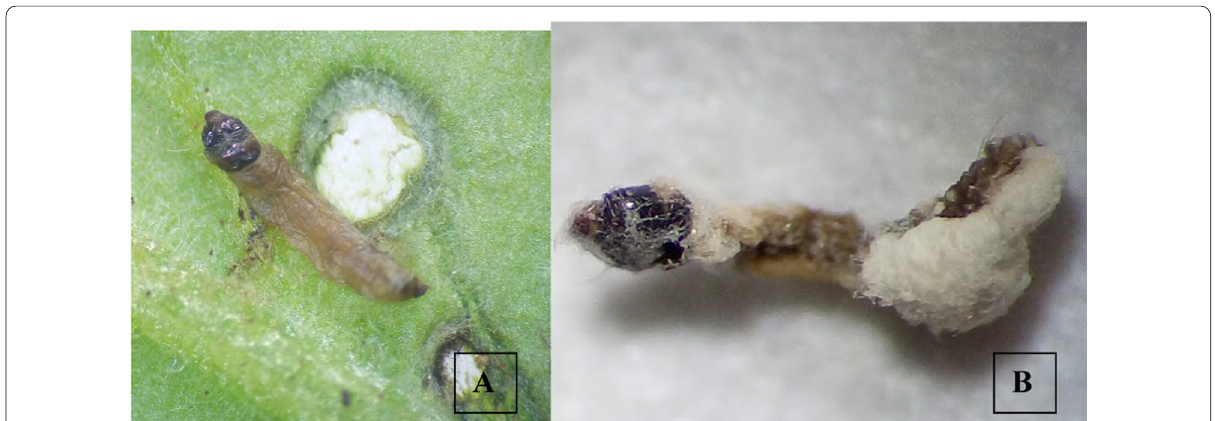
Fig. 4 Effect of Beauveria bassiana ATCC 74,040 against Tuta absoluta larvae. A : dead larva after 4 days of treatment; B : Development of mushroom mycelium on the body of the